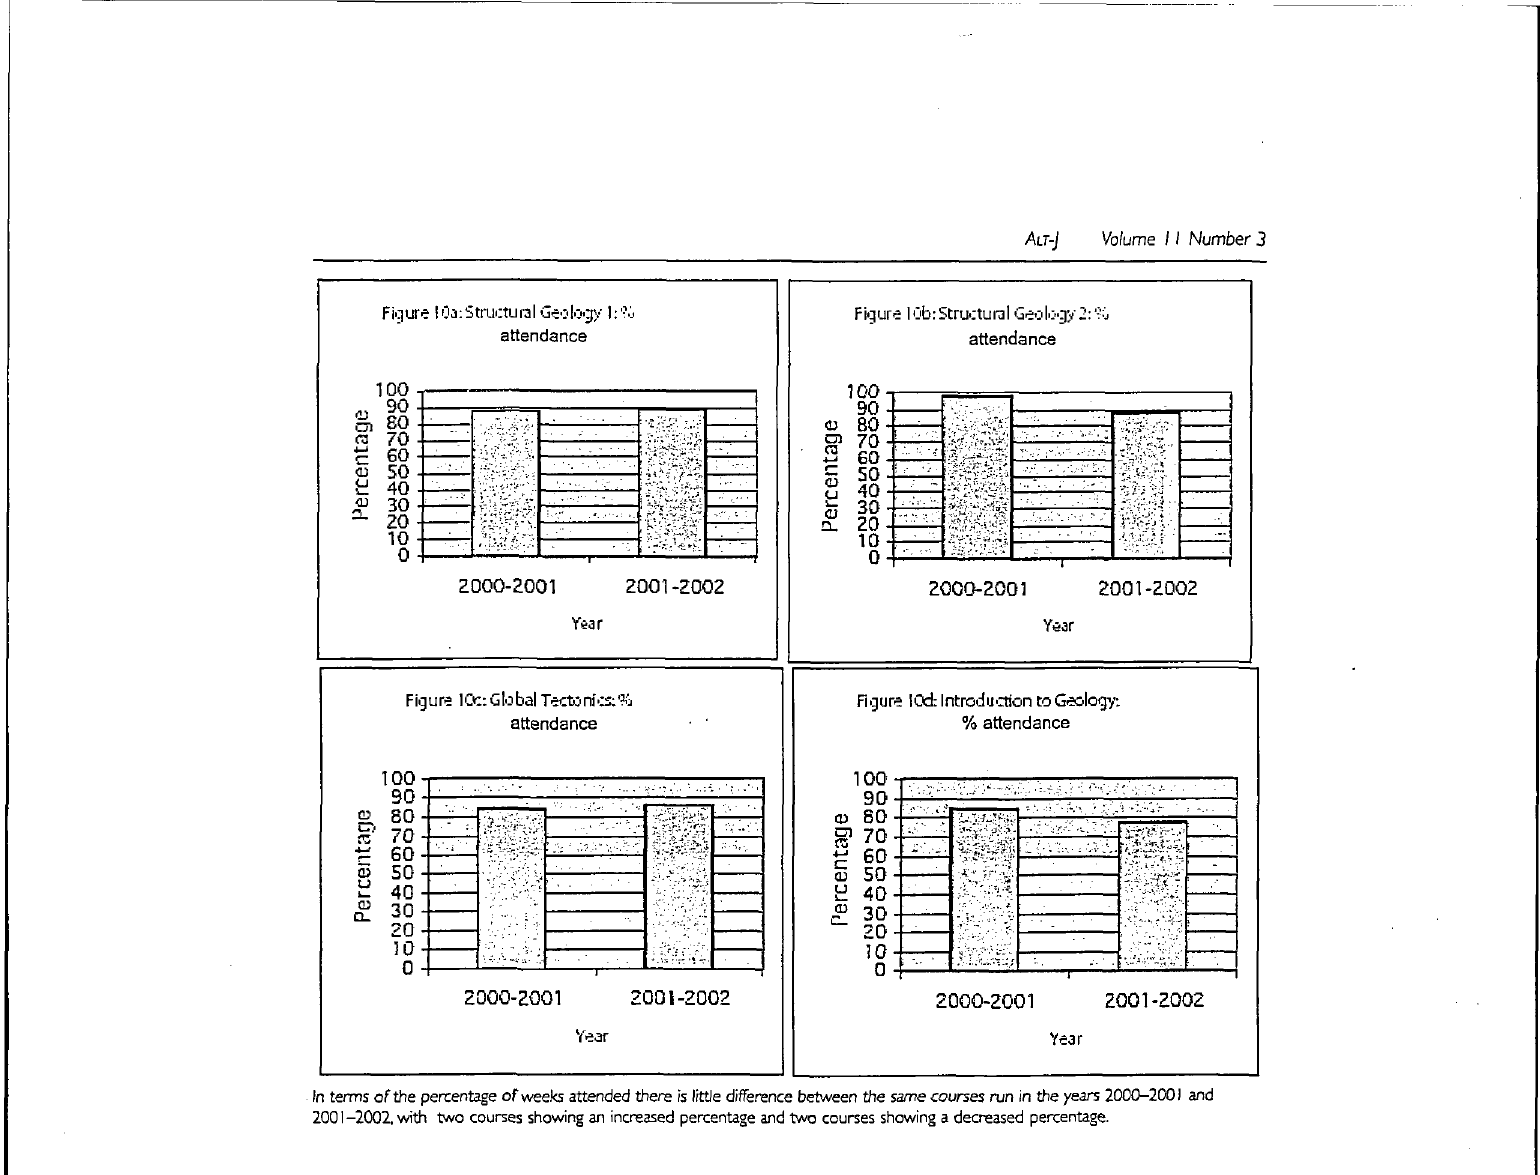
Figure lGc:GlobalTectonics;'?i